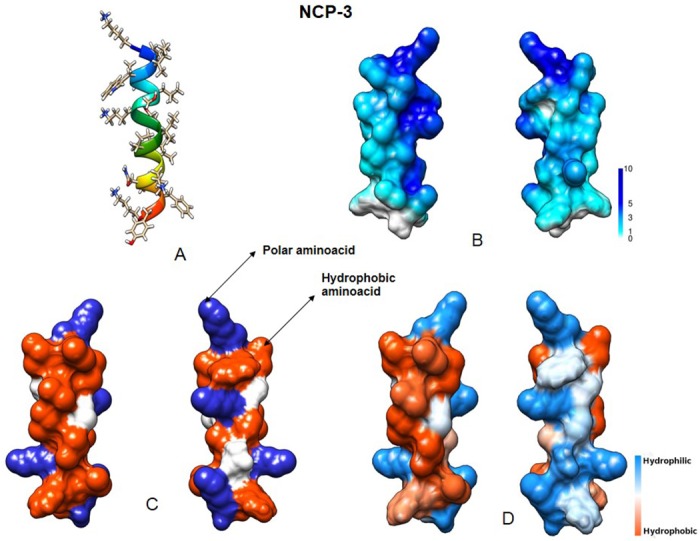
NCP-3 predicted structural features.(A) Three-dimensional structure. (B) Molecular surface colored by electrostatic potential (ranging from 1 to 10 kcal/(mol e)). (C) Distribution of basic (blue) and hydrophobic (red) amino acids. (D) Molecular surface colored by hydrophobicity (using the Kyte-Doolittle scale). Visualized using University of California, San Francisco (UCSF) Chimera.